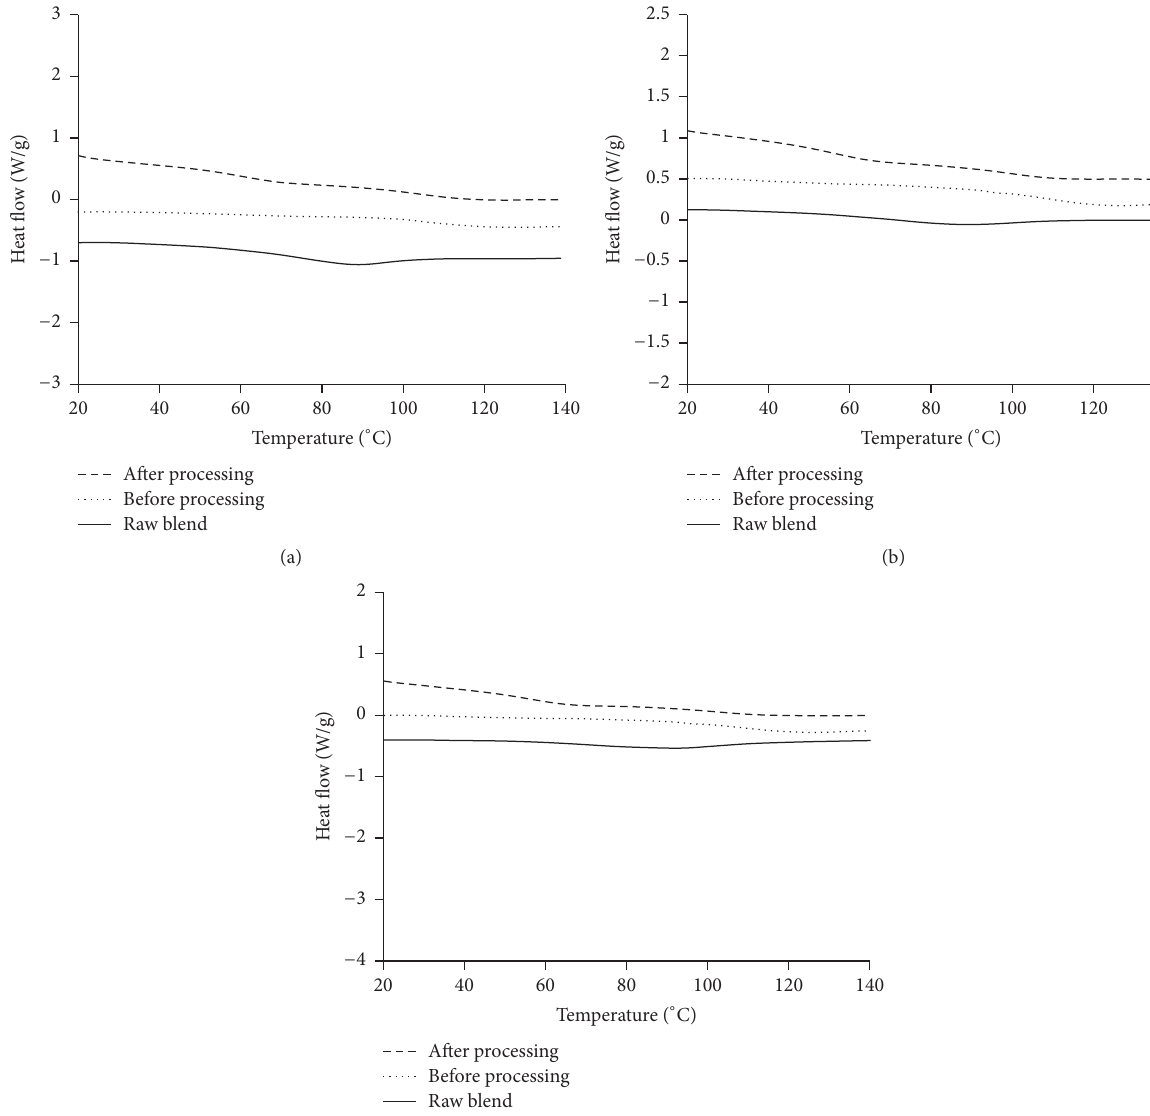
Figure 11: DSC Thermograms of blends between CGM and DDGS. (a) − 2 :1; (b) − 1: 1; (c) −